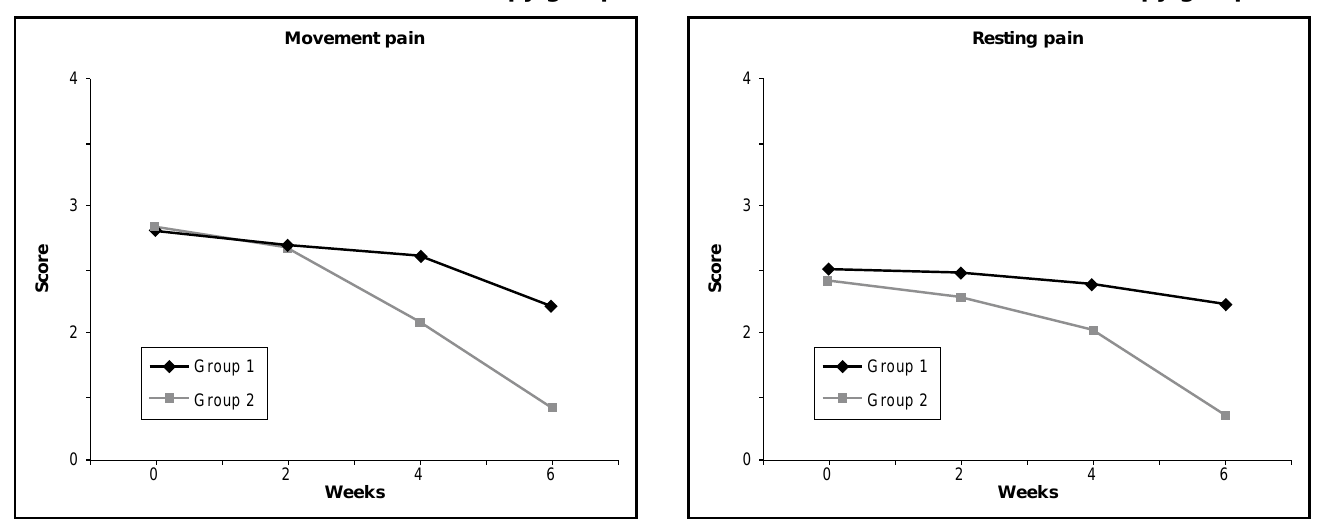
Figure 11: Development of movement pain for the six week-course of treatment in the therapy groups.